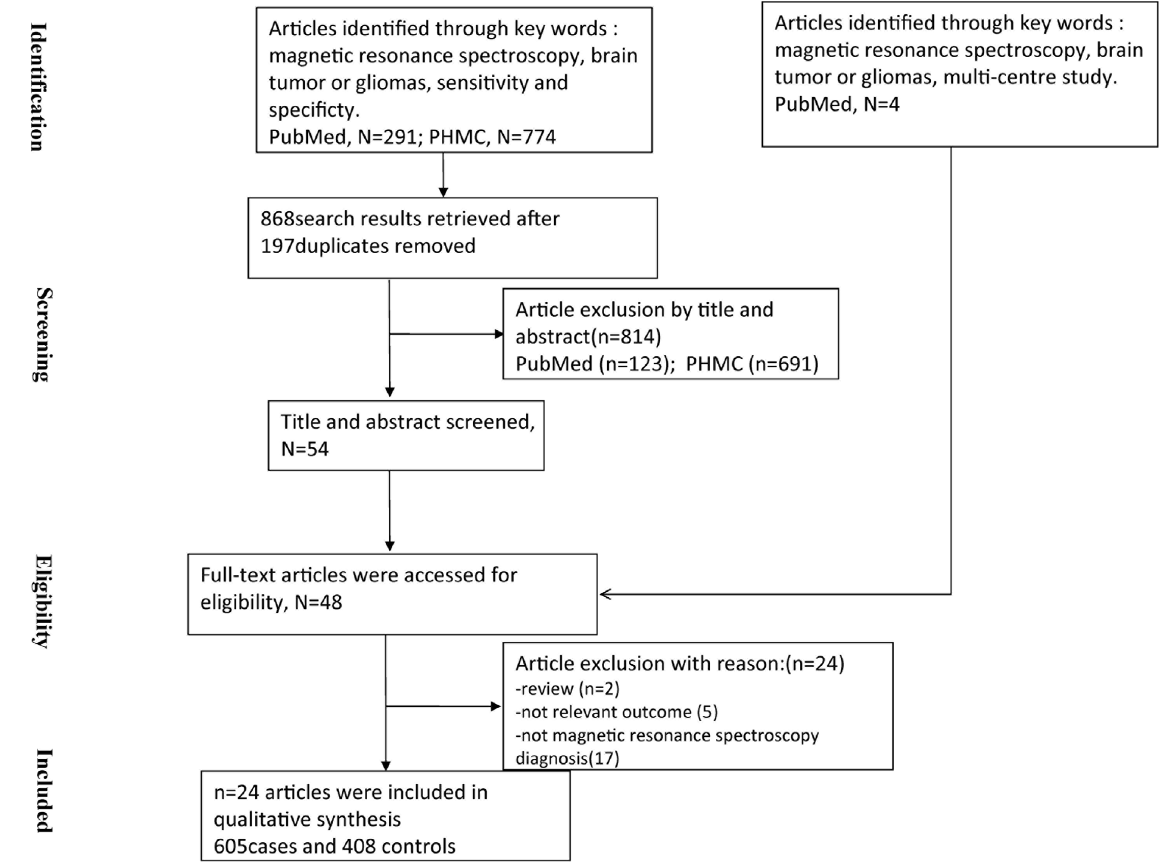
Figure 1. Flow chart showing the process of studies retrieved.